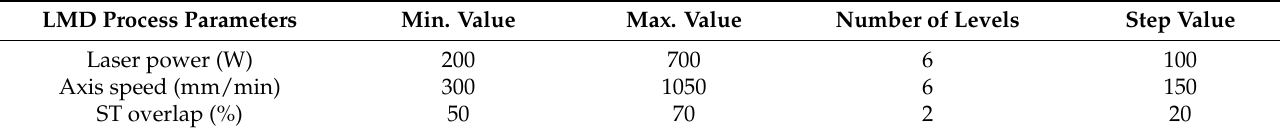
Table 2. Evaluated LMD process parameters for ST and SL depositions. LMD Process Parameters Min. Value Max. Value